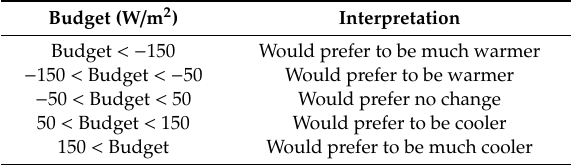
Table 4. Translation of energy budget values into people’s thermal comfort level [12].